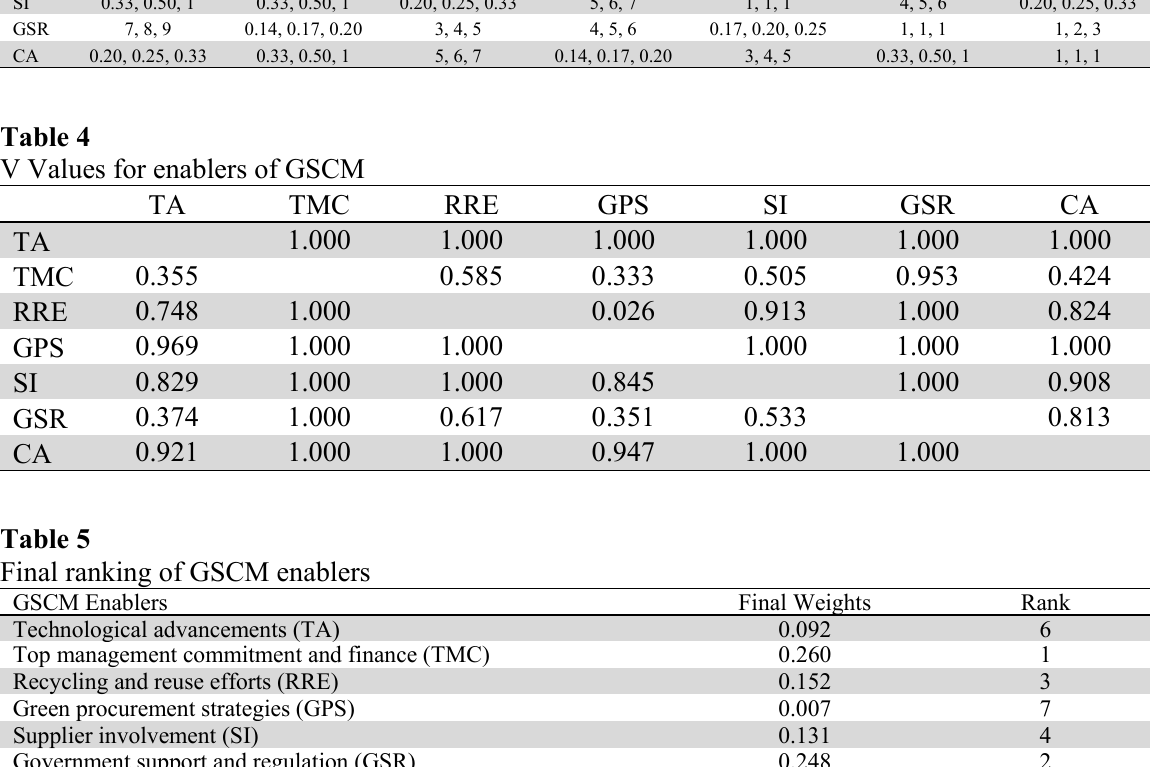
Fuzzy comparison matrix for green supply chain management enablers TA TMC RRE GPS TA